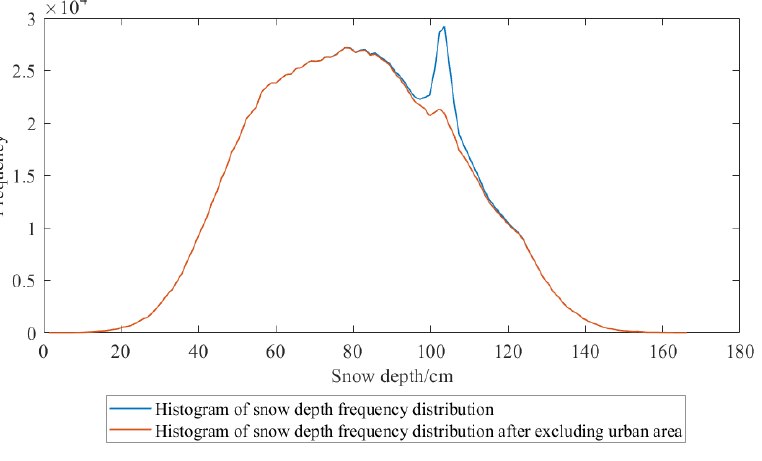
Figure 12. Histogram of snow depth frequency distribution.